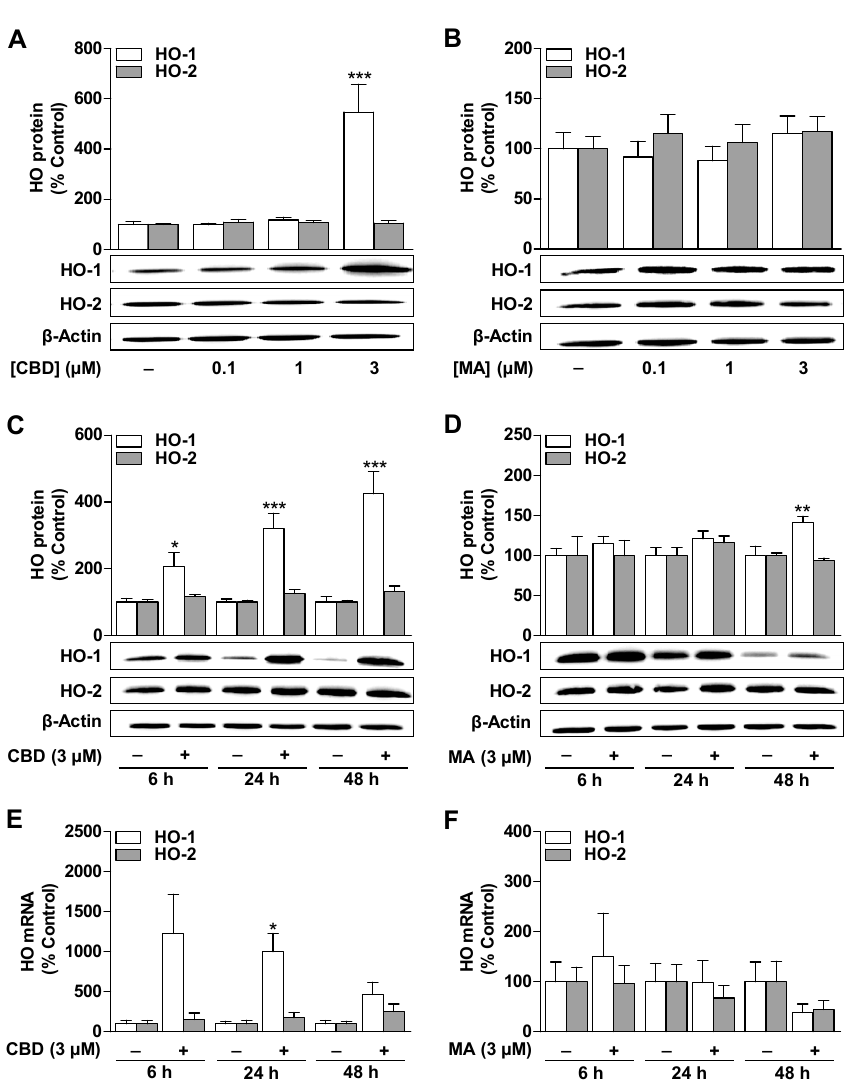
Figure 1. Impact of CBD and MA on the expression of HO-1 and HO-2 protein and mRNA in ADMSCs. Concentration-dependent effect of CBD ( A ) and MA ( B ) on the expression of HO-1 and HO-2 protein. The cells were incubated for 24 h with the indicated concentration of CBD and MA or with vehicle. Time-course of expression of HO-1 and HO-2 protein ( C , D ) and mRNA ( E , F ) in ADMSCs treated with CBD (3 µM), MA (3 µM), or vehicle. Protein and mRNA expression values were normalized to β -actin. The percentage control represents a comparison with the cells treated with vehicle (set to 100%) in the absence of the test substance. The data represent mean values ± SEM of n = 9 (( A ), HO-1), n = 8 (( A ), HO-2), n = 7 (( B ), HO-1), n = 4 (( B ), HO-2), n = 8 (( C ), HO-1), n = 7 (( C ), HO-2), n = 8 (( D ), HO-1), n = 4 (( D ), HO-2), or n = 3 ( E , F ) different donors. * p < 0.05, ** p < 0.01, *** p < 0.001 vs. time-matched vehicle control; one-way ANOVA with Dunnett’s post hoc test ( A , B ) or Student’s two tailed t test ( C – F ).